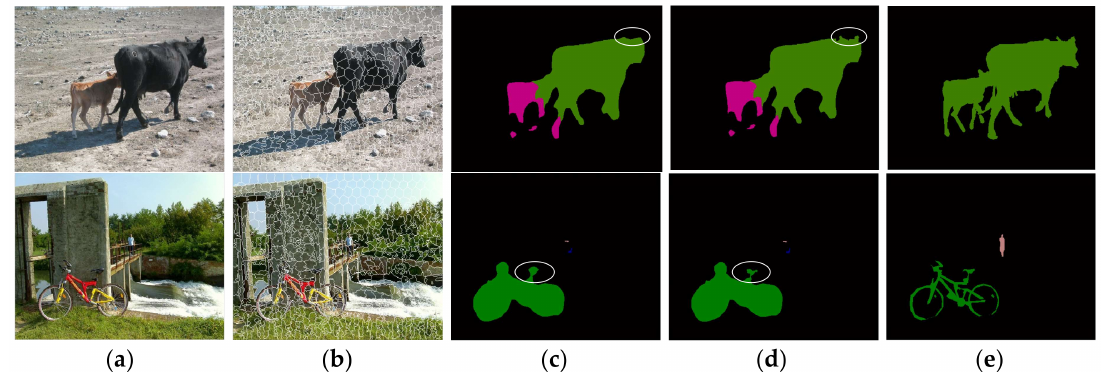
Figure 8. Combination FCN and BSLIC to acquire more details of a target. ( a ) The original test images; ( b ) The BSLIC superpixel segmentation results; ( c ) The FCN-8S semantic segmentation results; ( d ) The results of the improved model proposed in this paper; and, ( e ) The ground truth.